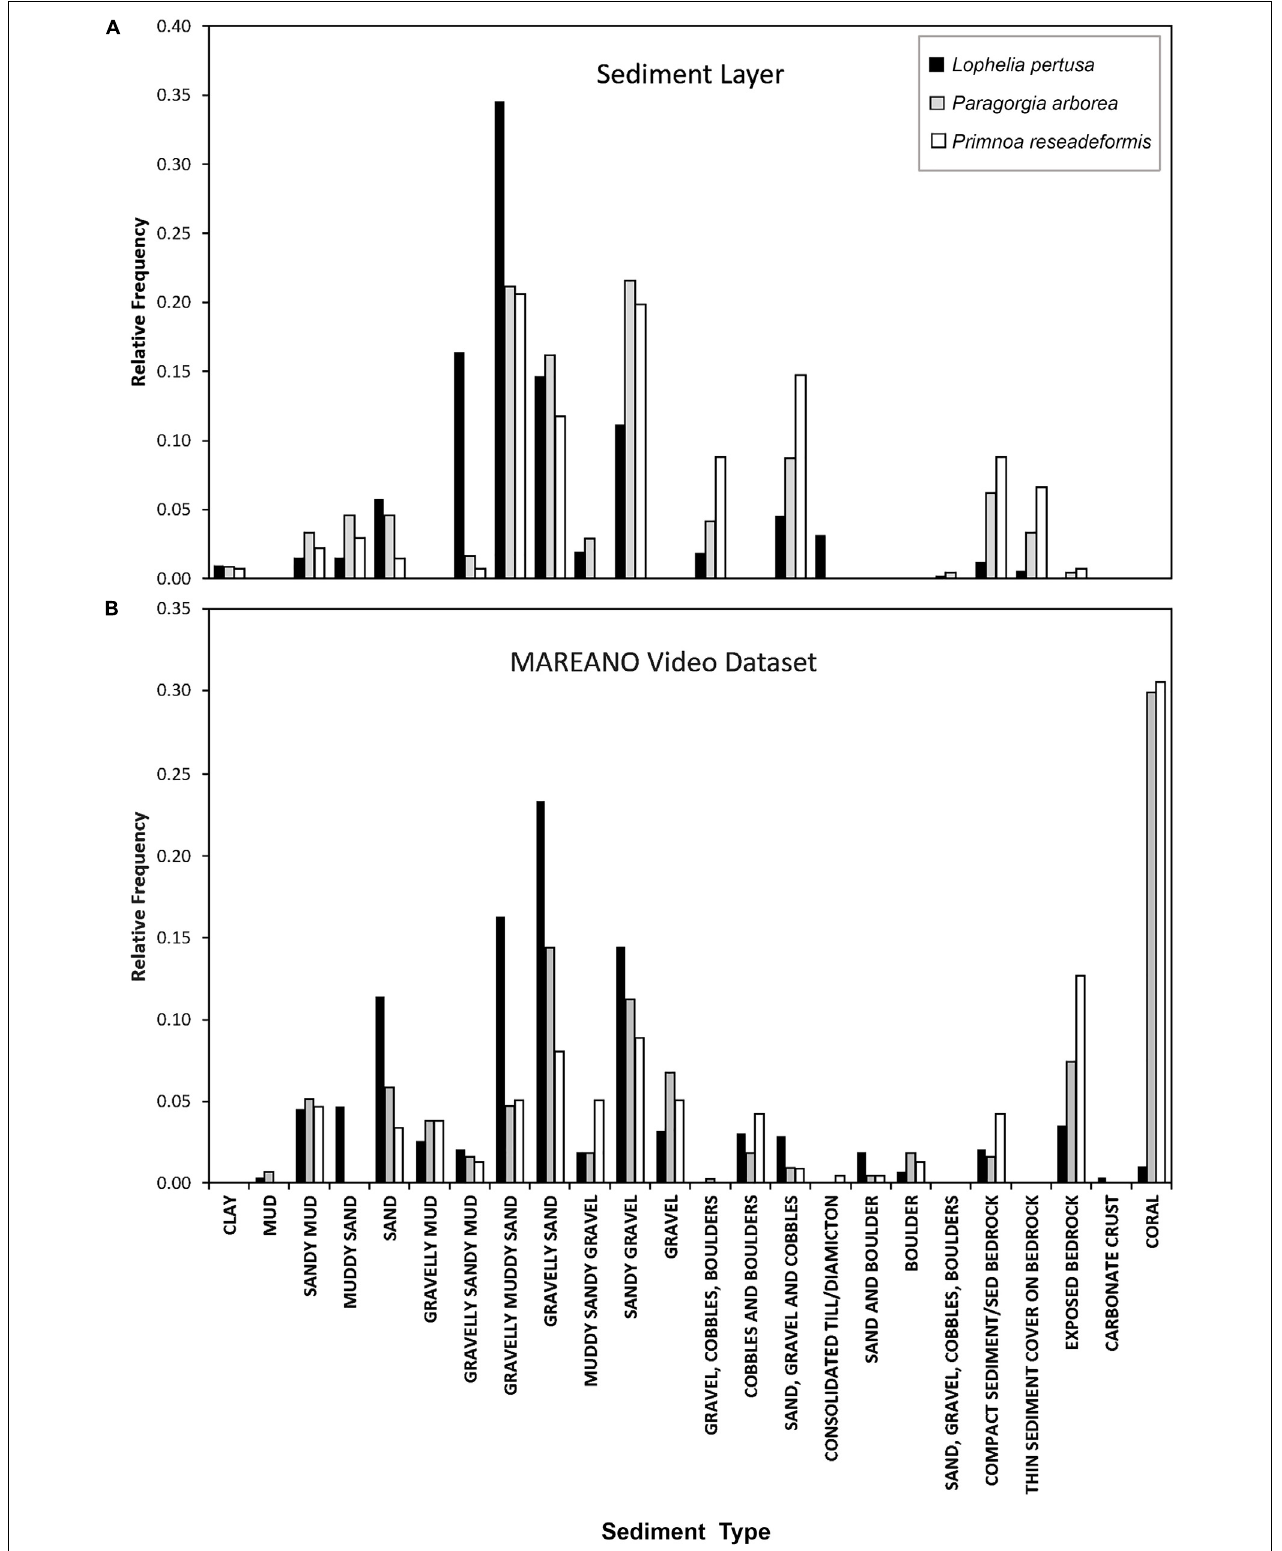
FIGURE 5 | Relative frequency of sediment types for each coral species at their sites of occurrence from the MAREANO sediment layer (A) , compared with the observed sediment type from the MAREANO video dataset (B) .